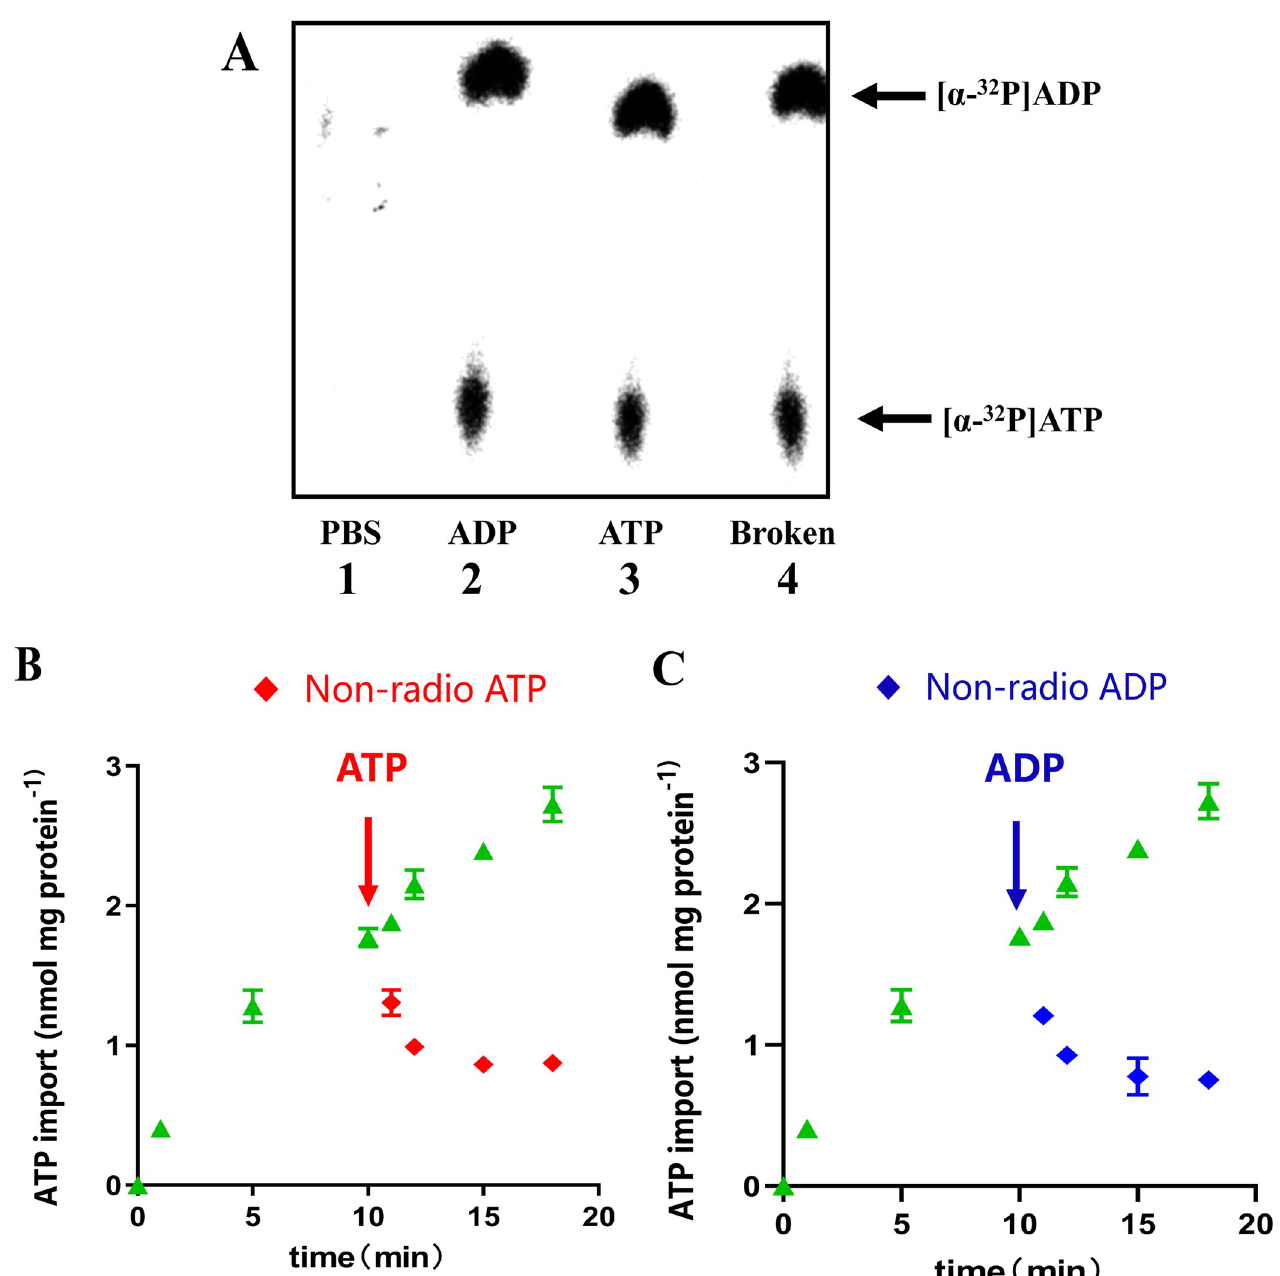
Fig 3. Back exchange experiments with E . coli cells. (A) E . coli cells expressing TgANT were preloaded with 50nM radioactive [ α - 32 P] ATP for 5 min, followed by carried out back exchange experiment with 5 μ M non-labeled ATP, ADP, or PBS for 3 min and terminated by rapid centrifugation. Then, 2 μ L sample of the supernatant were loaded onto the TLC PEI cellulose plate. The supernatant of the broken E . coli cells was used to detect the metabolic activity (lane 4). (B) and (C) E . coli cells harboring the plasmid encoding TgANT were incubated with 50 nM [ α - 32 P] ATP for 10 min. Then, efflux was induced by the addition of fifty-fold unlabeled ATP (B) or ADP (C) for 1min, 2min, 5min and 8min. Means ± s.e.m., three independent